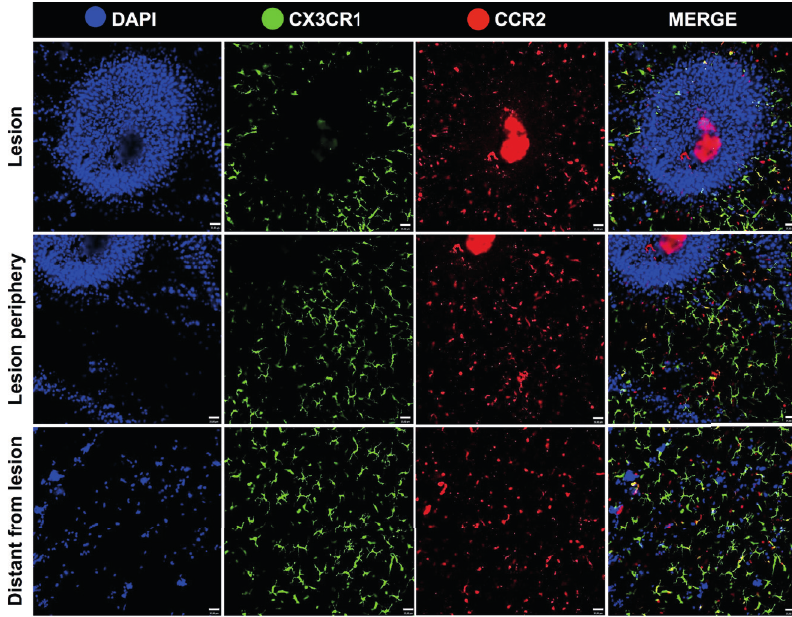
Figure 7 - Dynamics of phagocytic populations under liver injury. Assessing migration dynamics of CX3CR1+ (green) and CCR2+ (red) to three diff erent areas simultaneously using the multi-point imaging feature of Nikon A1R (necrotic zones, areas around necrosis and areas distant from necrosis) by intravital microscopy. A focal thermal necrosis was induced using a hot needle adapted to a cauterizer unit. The hot needle touched the liver surface and resulted on a punctual necrosis, which is delimited with topic DAPI staining (in blue). Scale bars = 35